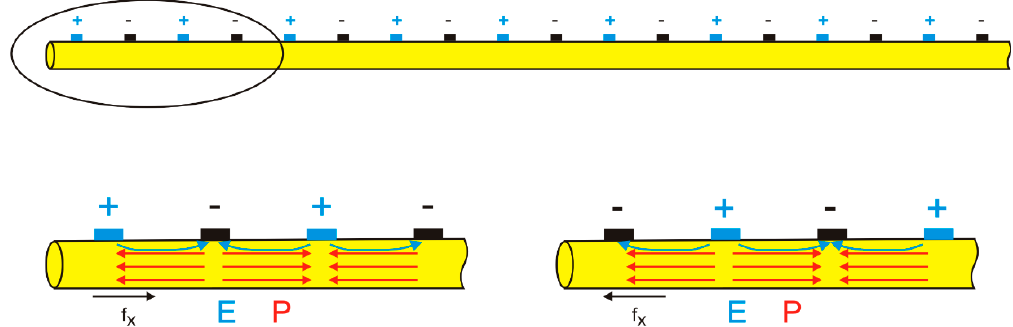
Figure 2. A cross-section of the piezoelectric fiber patch (PFP) shown in Figure 1 along the line A–A (a corrected version of Figure 4 in [10]). The upper row shows the fiber with electrodes; the lower row is a magnification of the left fiber’s end. The application of electric voltage in the two orientations leads to electric fields ( E ) that are antiparallel (left) and parallel (right) to the polarization ( P ). Simply speaking, a resulting force ( f x ∼ σ xx , x ) is generated where the product σ xx ∼ P x E x is changing from an average value to zero; that is, at the end of the polarized region of the fiber [22].